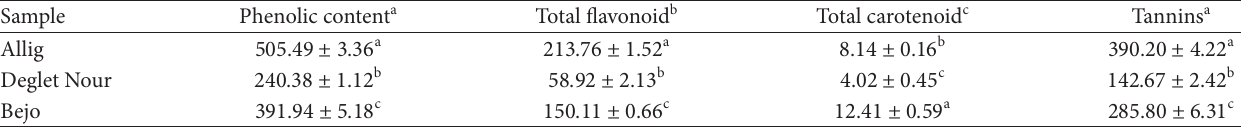
Table 1: Content of total phenolic, total flavonoid, total carotenoid, and tannins in different date